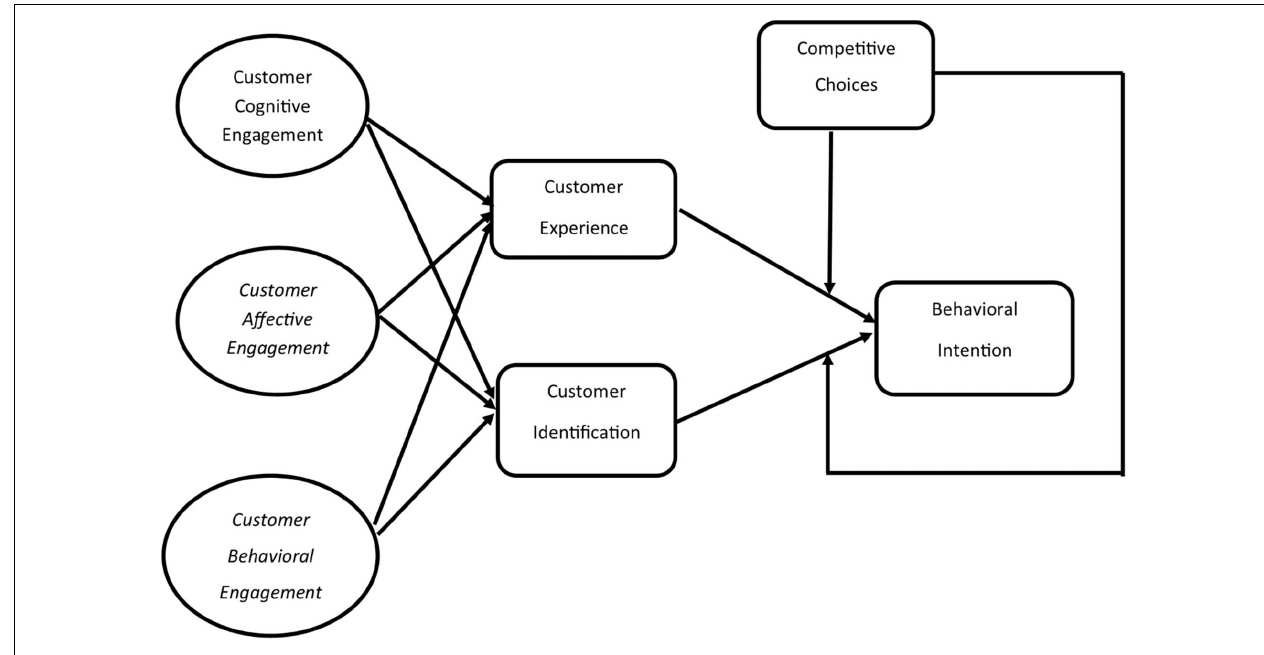
FIGURE 1 | Research model of the